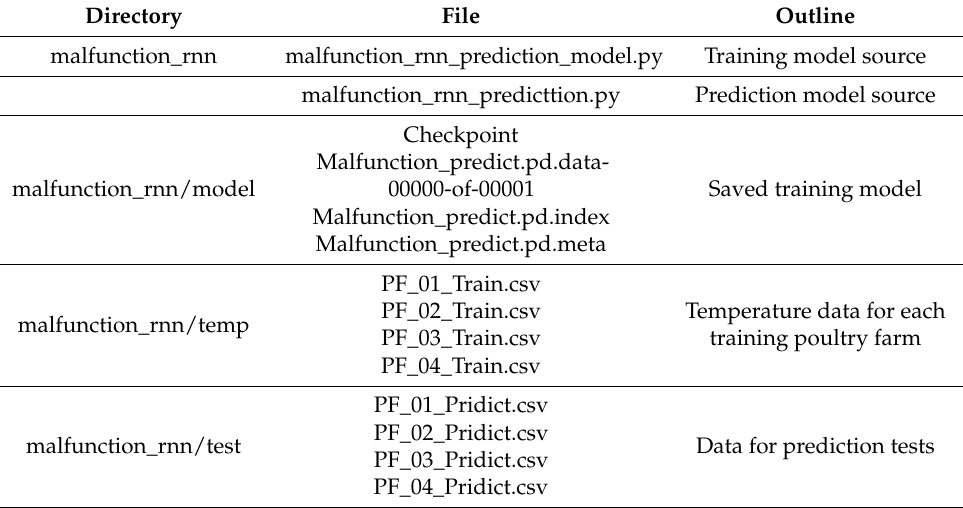
Table 4. File structure of the prediction model for malfunction detection.